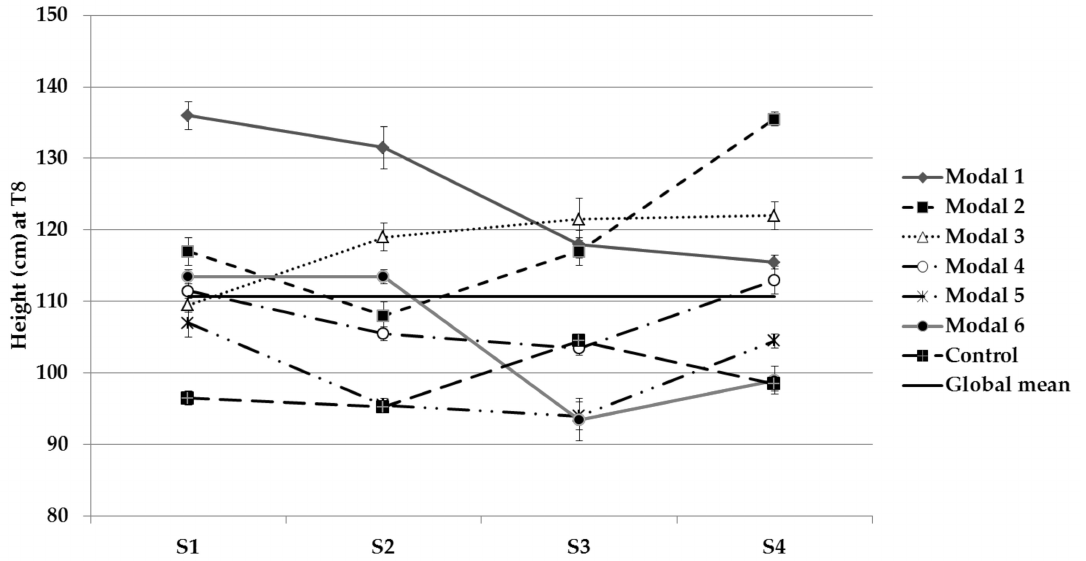
Figure 7. Graph of means of stem length (on the vertical axis) for each modality tested according to the different substrates (on the horizontal axis), 8 weeks after planting. S1 = 100% coconut fiber; S2 = 66% coconut fiber + 33% bagasse; S3 = 50% coconut fiber + 50% bagasse; S4 = 33% coconut fiber + 66% bagasse). Modality 1 = AMF (strain IP21); modality 2 = AMF (strain IP21) + Trichoderma harzianum ; modality 3 = AMF (strain IP21) + Pseudomonas fluorescens (strain IPB04); modality 4 = AMF (strain IP21) + Trichoderma harzianum + Pseudomonas fluorescens (strain IPB04); modality 5 = commercial AMF product containing 6 AMF strains; modality 6 = commercial AMF product containing 6 AMF strains + Trichoderma harzianum. Confidence level was